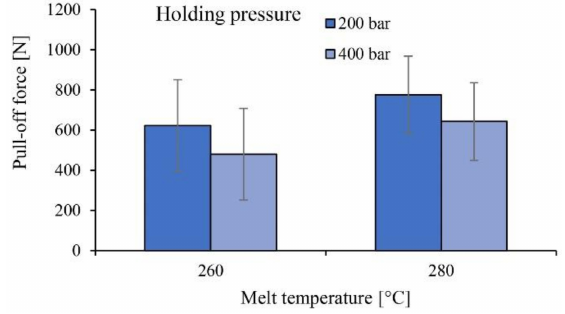
Figure 5. The pull-off force as a function of holding